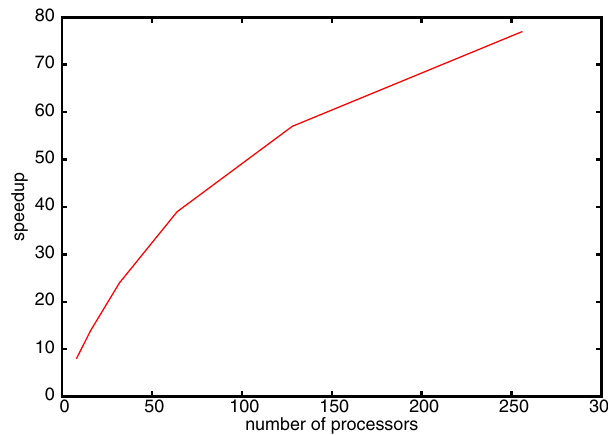
FIG. 10. (Color) Speedup of the parallel implementation as a function of processor number on an IBM SP3 supercomputer.